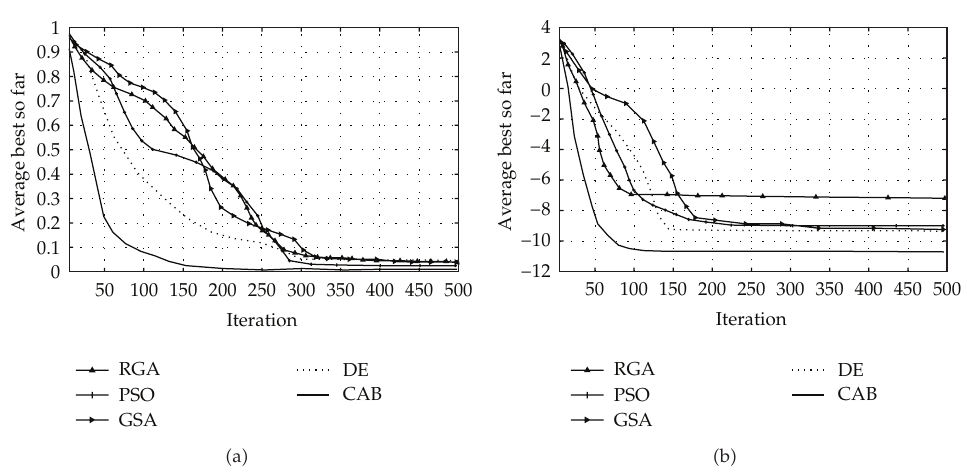
Figure 4: Performance comparison of RGA, PSO, GSA, DE, and CAB for minimization of (cid:2) a (cid:3) f 15 and (cid:2) b (cid:3) f 22